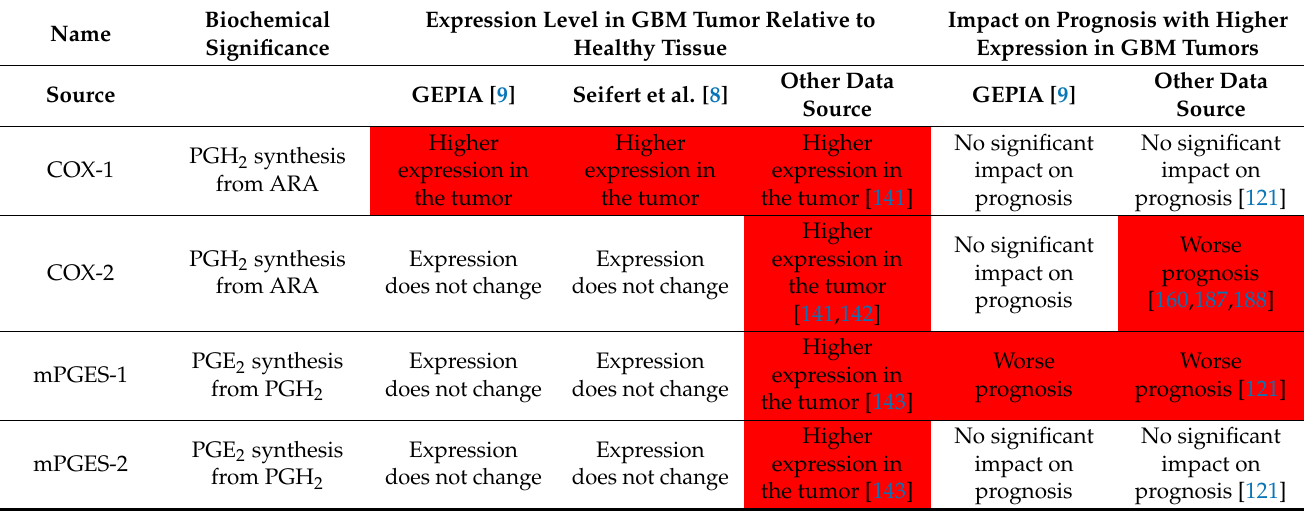
Table 5. Description of individual enzymes involved in the synthesis, transport, and degradation of